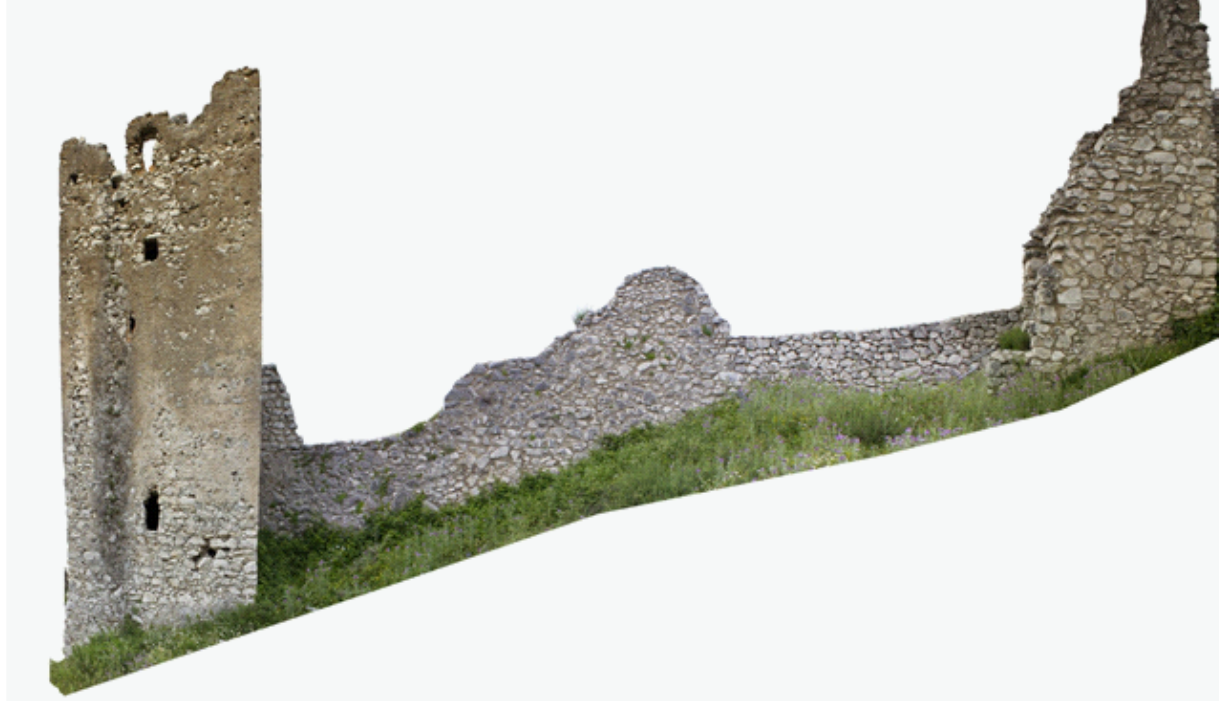
Figure 1 3 : orthophoto-mosaics of the east